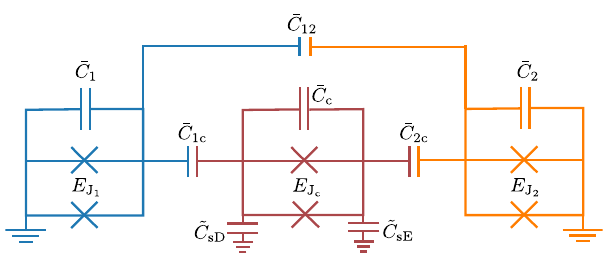
FIG. 8. A schematic of the reduced effective circuit of the floating-coupler setup. The capacitances are defined in Eq.